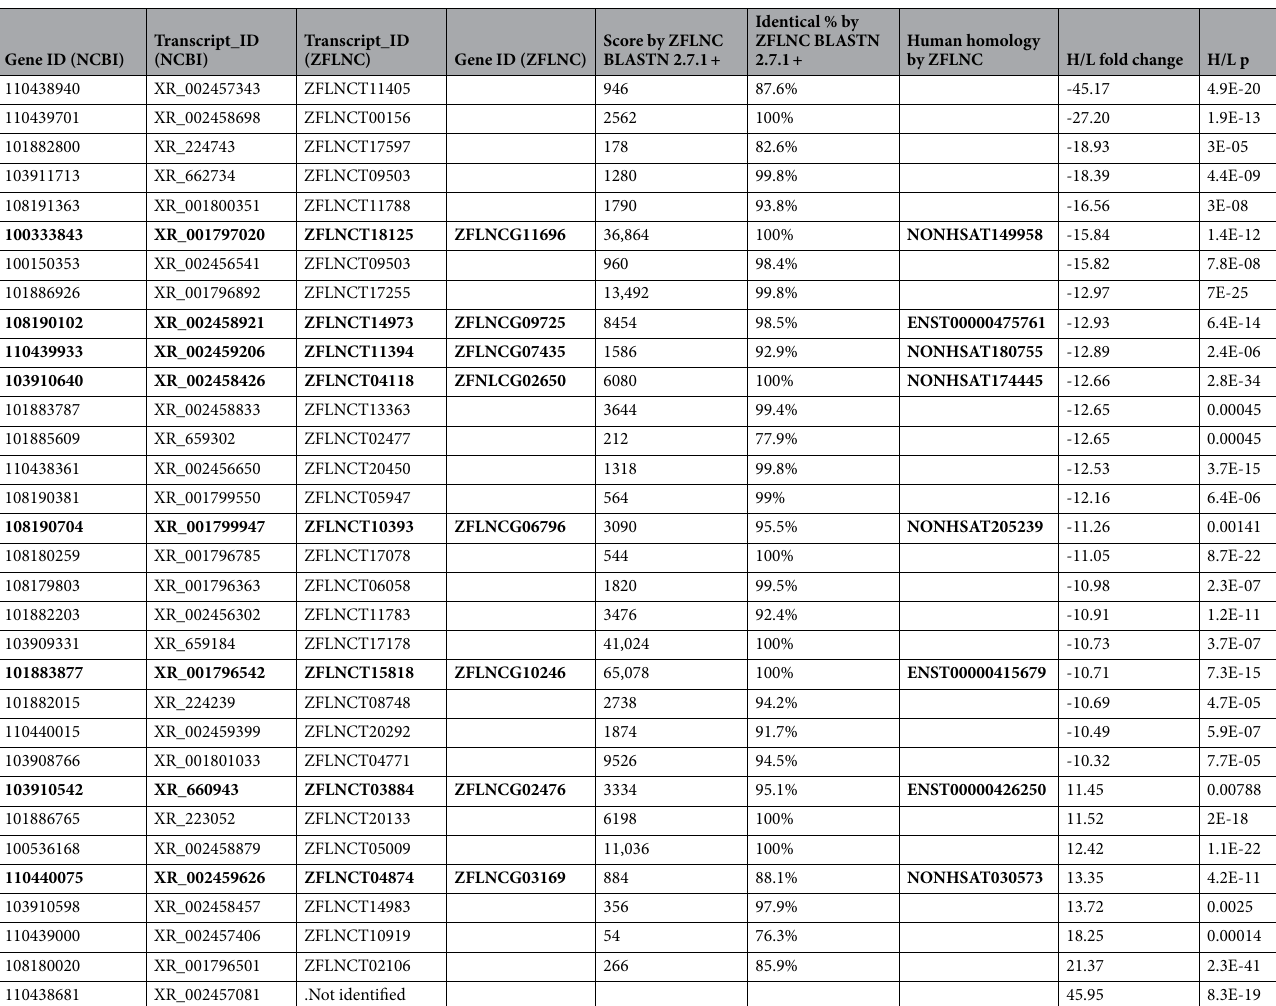
Table 2. Next-generation sequencing analysis; 8 candidates of human homologs by ZFLNC. H high, L low, p p value, E−20 × 10 –20